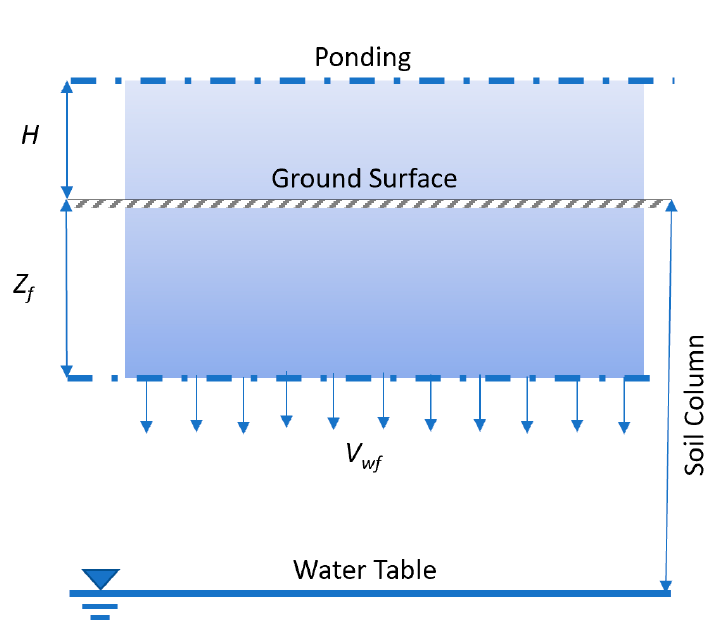
Figure 4. Governing factors for vertical water movement in the Green–Ampt method. H, ponding head ; Z f , saturated wetting front below the ground; V wf , velocity of wetting front. ICPR estimates h c based on moisture content and bubble pressure from soil data (Table 1).